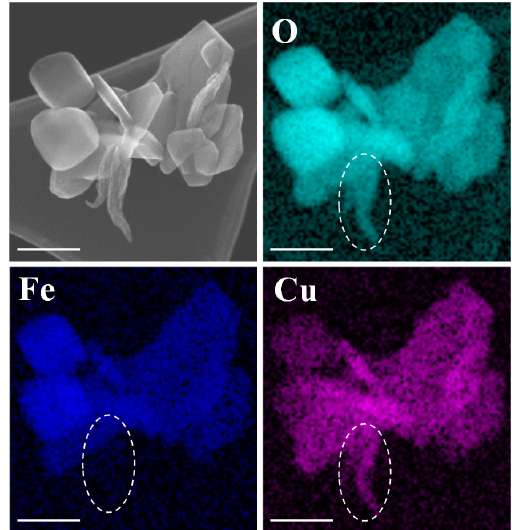
Figure 4. EDS mapping (elements of O, Fe, and Cu) of a Cu x Fe y O z (S500) NP cluster. The scale bars represent 100 nm. The dashed-oval outlines the Cu 2 O NPs.